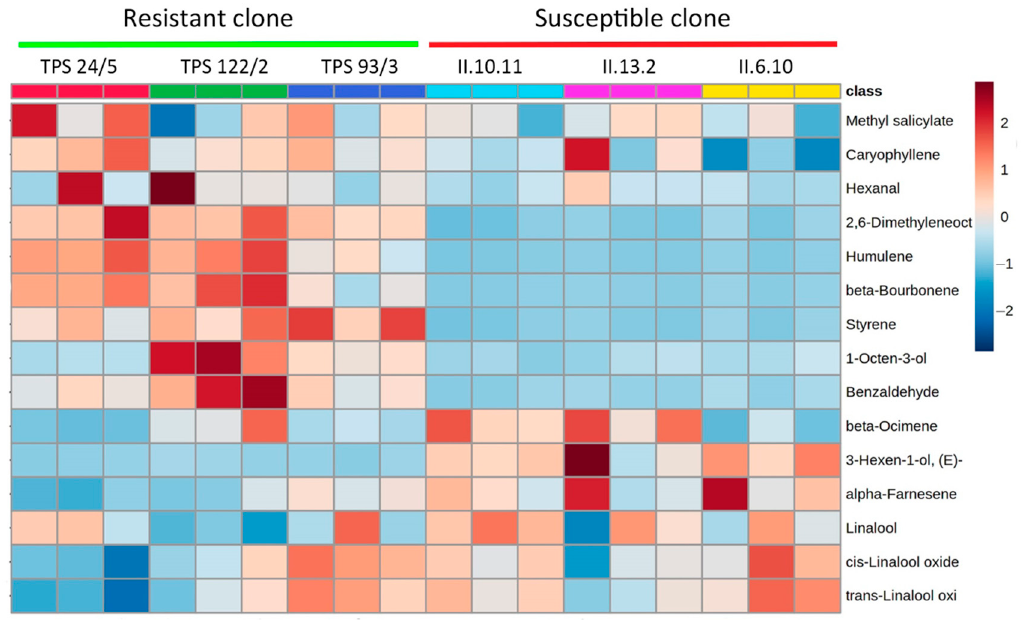
Figure 4. Heatmap cluster based on the normalized quantities of the volatile compounds identified in the tea clones. The color indicators indicate relative amounts of the compounds. The darkest blue indicates the least amount of a compound and the darkest red the most.